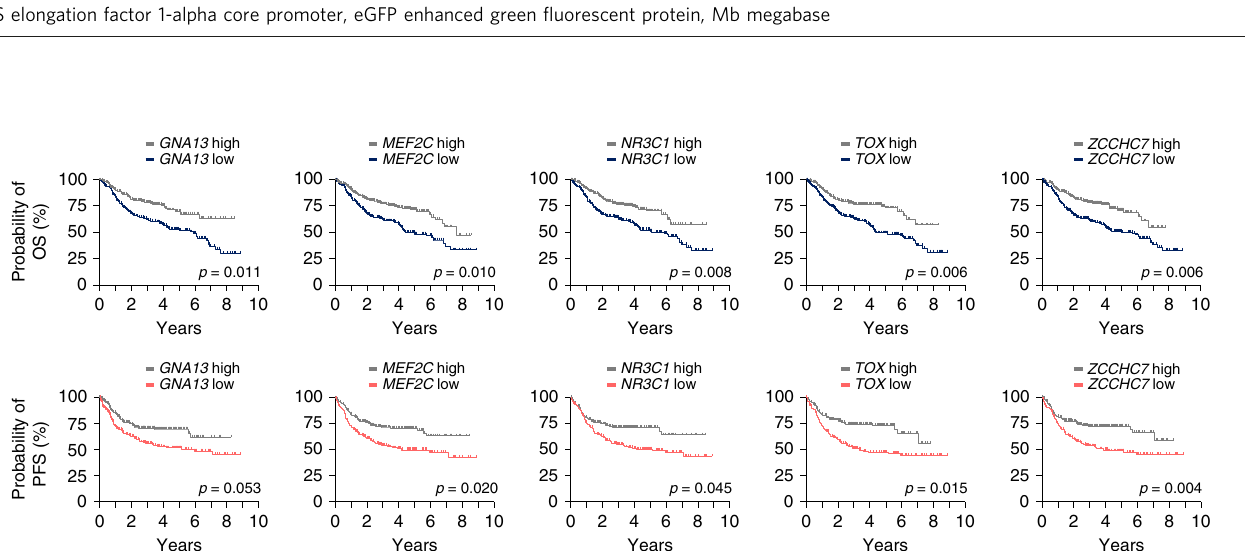
Fig. 7 A CRISPR/Cas9-based in vivo platform for BCL functional genomics. a Outline of the functional genomic approach for in vivo gene validation. b Kaplan – Meier plot showing survival of mice transplanted with hematopoietic stem/progenitor cells (HSPC) transduced with Trp53 sgRNA, Trp53 shRNA, and non-targeting (NT) sgRNA. p < 0.0001 for both Trp53-sgRNA vs. NT-sgRNA and Trp53-shRNA vs. NT-sgRNA. p < 0.03 for Trp53-sgRNA vs. Trp53- shRNA. p -values (log-rank test) were corrected for multiple testing using the Bonferroni method. c The transposon insertion pattern in Rfx7 predicts that gene-disruption is the cancer-causing mechanism. Each arrow represents an individual insertion. Insertions from all DLBCLs in the cohort are shown. ITP2 transposons can trap genes in either orientation. Insertions are distributed over the whole length of the gene (predicting a tumor suppressor). There is no bias for hot-spot areas of insertions as typically observed for unidirectional "activating" insertions in oncogenes. Consensus coding sequence ( Rfx7-201 ) is displayed. d Kaplan – Meier plot for mice transplanted with HSPCs transduced with Rfx7 sgRNA and NT sgRNA. p < 0.0001, log-rank test. e Transposon insertion pattern in Phip , predicting tumor suppressive function of the gene. Consensus coding sequence ( Phip-201 ) is shown. Each arrow represents an individual insertion. Insertions from all DLBCLs in the cohort are shown. f Heatmap displaying copy number variations on human chromosome 6 in samples from the TCGA-DLBC ( n = 48) dataset (TCGA Research Network: http://cancergenome.nih.gov). The position of PHIP is indicated. g Function of Phip as a B-cell lymphoma tumor suppressor was validated using the CRISPR/Cas9-based in vivo functional genomic approach. Kaplan – Meier plot for mice transplanted with HSPCs transduced with Phip sgRNA and non-targeting (NT) sgRNA transplants. p < 0.0001, log-rank test. sgRNA single guide RNA,